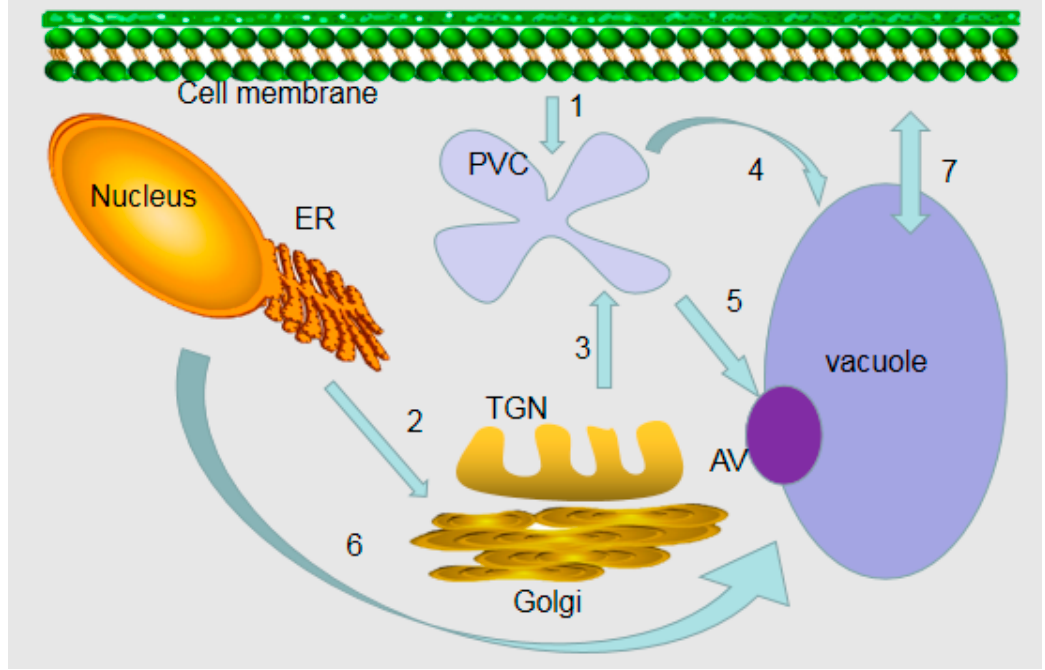
Figure 1. Model for the formation of plant vacuoles. (1) Endocytosis from the cell surface to a prevacuolar compartment (PVC). (2) Early secretory pathway from the endoplasmic reticulum (ER) to the late Golgi compartment. (3) Proteins are sorted into the PVC by an early biosynthetic